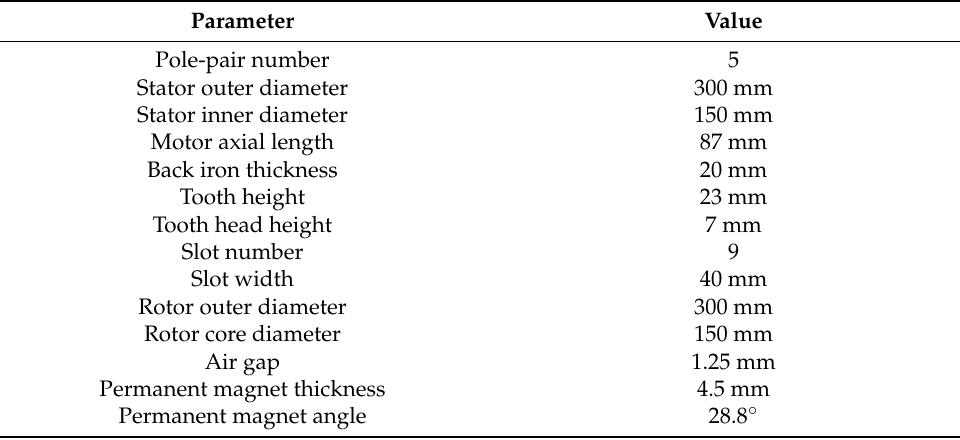
Figure 4. 3D model of the DSSR AFPM motor. Table 4. Specification of the DSSR AFPM motor.